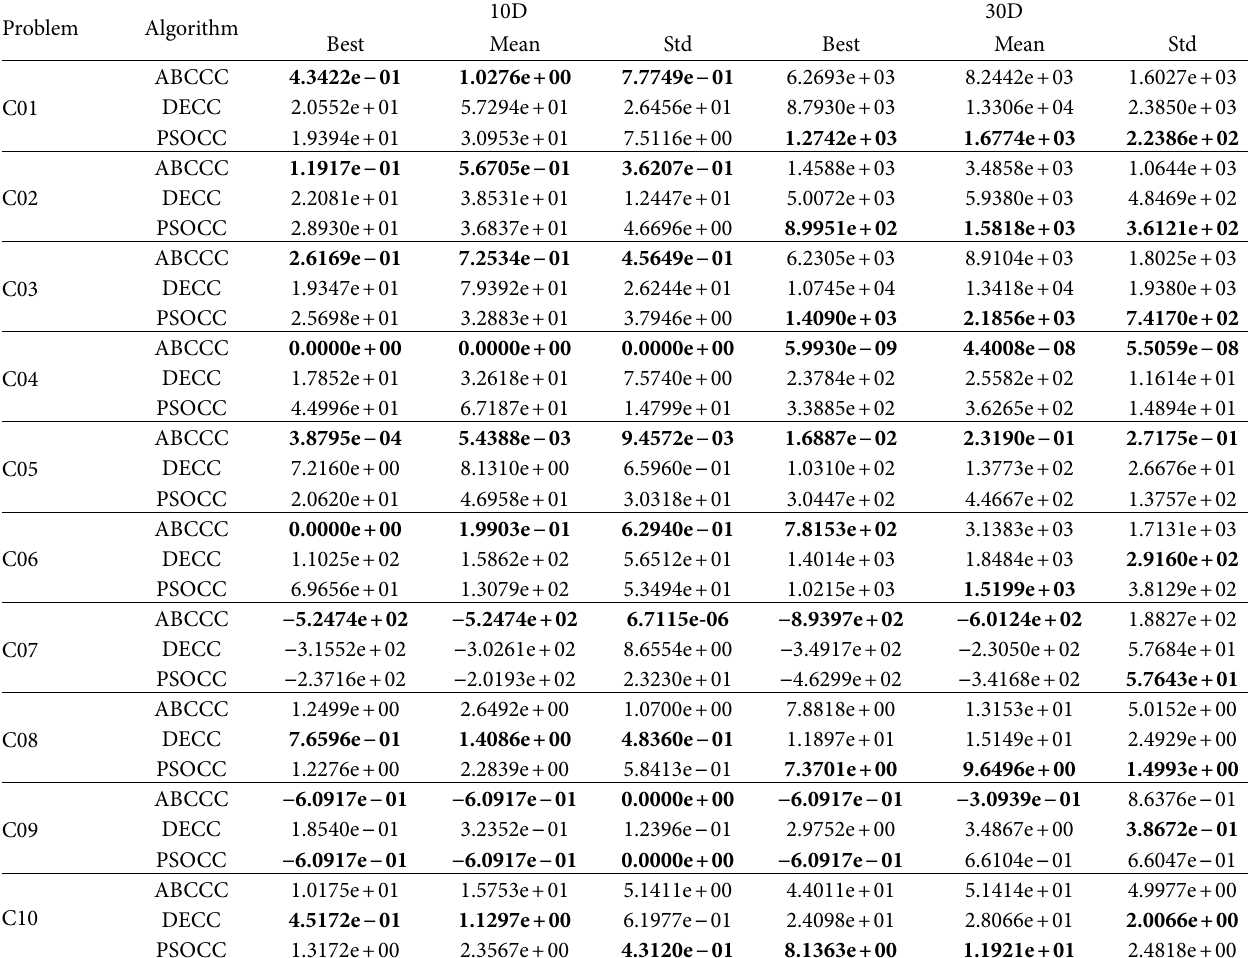
Table 5: Comparison results of the proposed algorithm with other two